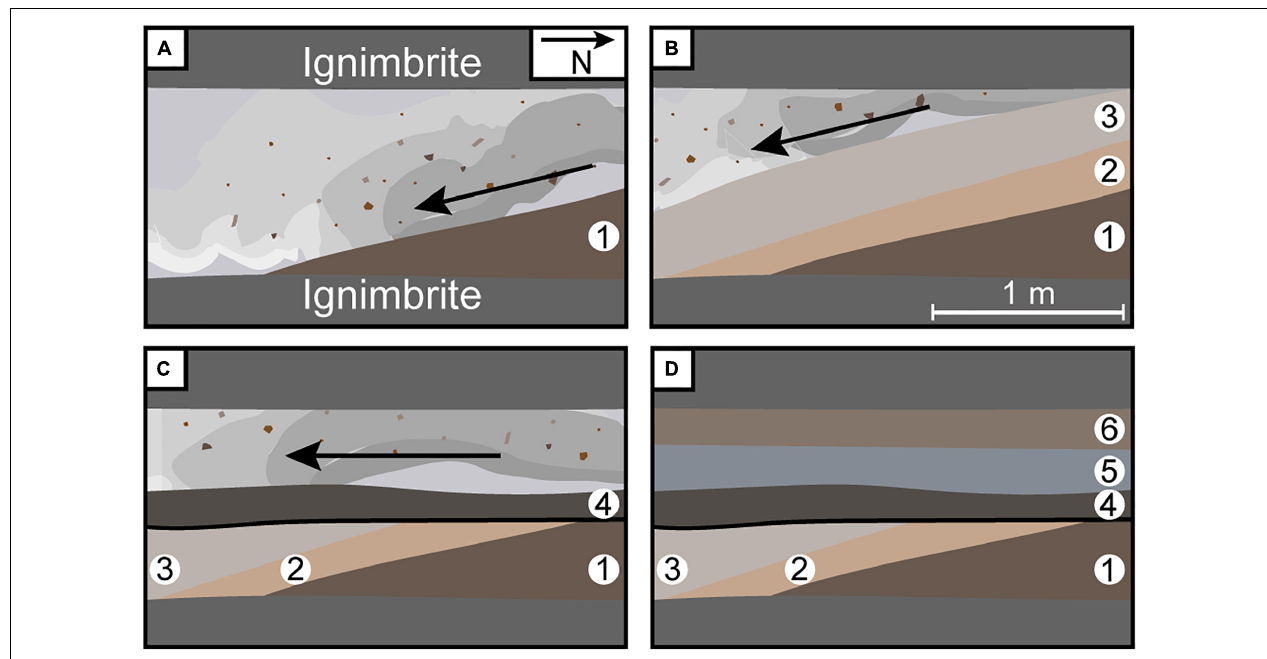
FIGURE 9 | Schematic showing the deposition of southwards dipping units in the tuffisite. (A) Fluid flow toward the south deposits a tuffisite unit (1) with a shallow angle. (B) The next tuffisite units (2 and 3) are deposited above, also dipping at a shallow angle to the south, producing a laterally migrating structure. (C) An increase in fluid velocity, driven by a fluctuation in fluid pressure, allows the previous material to be eroded. The next tuffisite unit (4) is unconformably deposited above. (D) The final tuffisite units (5 and 6) are